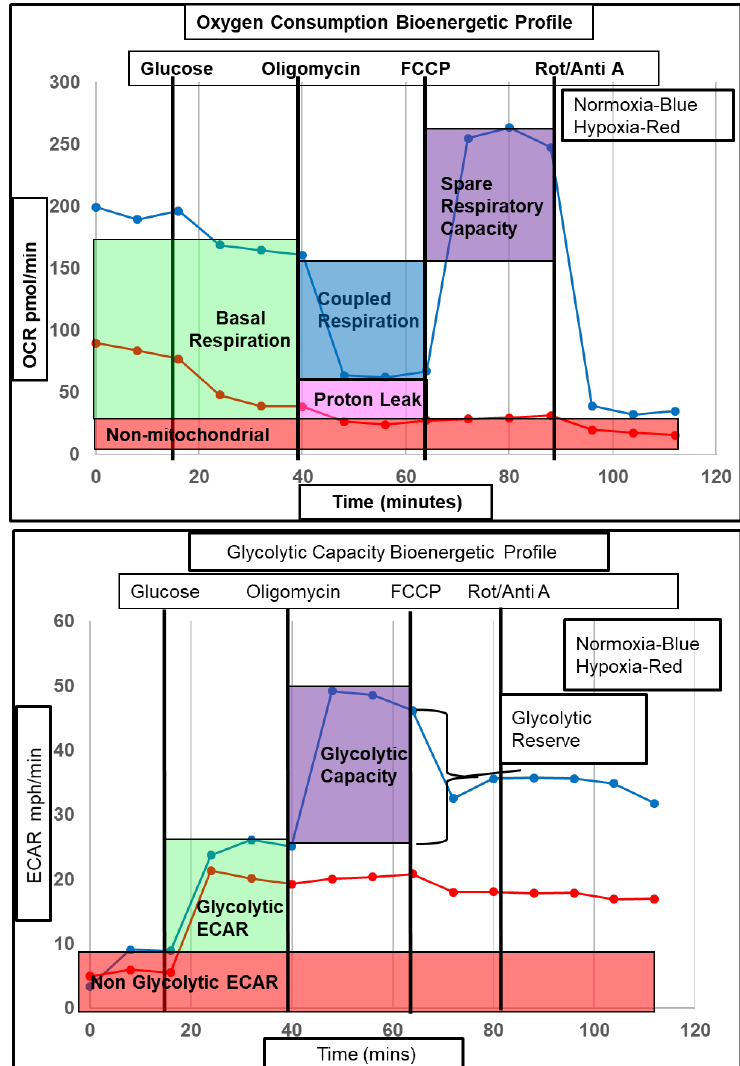
Figure 7. Representative bioenergetic profile of astrocyte mitochondrial oxygen consumption and glycolytic flux during hypoxia. ( Upper panel ) Representative astrocyte mitochondrial oxygen consumption bioenergetic profile, showing the response of astrocyte oxygen consumption to injection of glucose, oligomycin, carbonyl cyanide p-trifluoromethoxy phenylhydrazone (FCCP), and rotenone/antimycin A. Blue line = normoxia, red line = hypoxia; ( Lower panel ) Representative astrocyte glycolytic flux bioenergetic profile showing the response of astrocyte glycolytic flux to injection of glucose, oligomycin, FCCP and rotenone/ antimycin A. Blue line = normoxia, red line = hypoxia. OCR = oxygen consumption rate, ECAR = extracellular acidification rate.